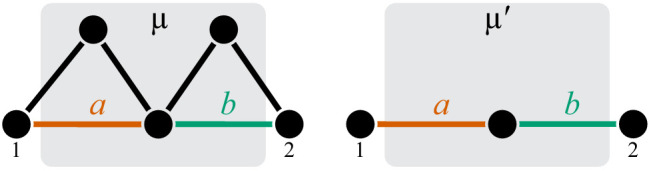
A counter example illustrating that the converse to claim 2 in Proposition 4 may not be true.Reactions a and b are parallel in (μ,a,b). CGP maps the double-marked module (μ,a,b) onto the minimal double-marked module (μ′,a,b) where reactions a and b are not parallel.